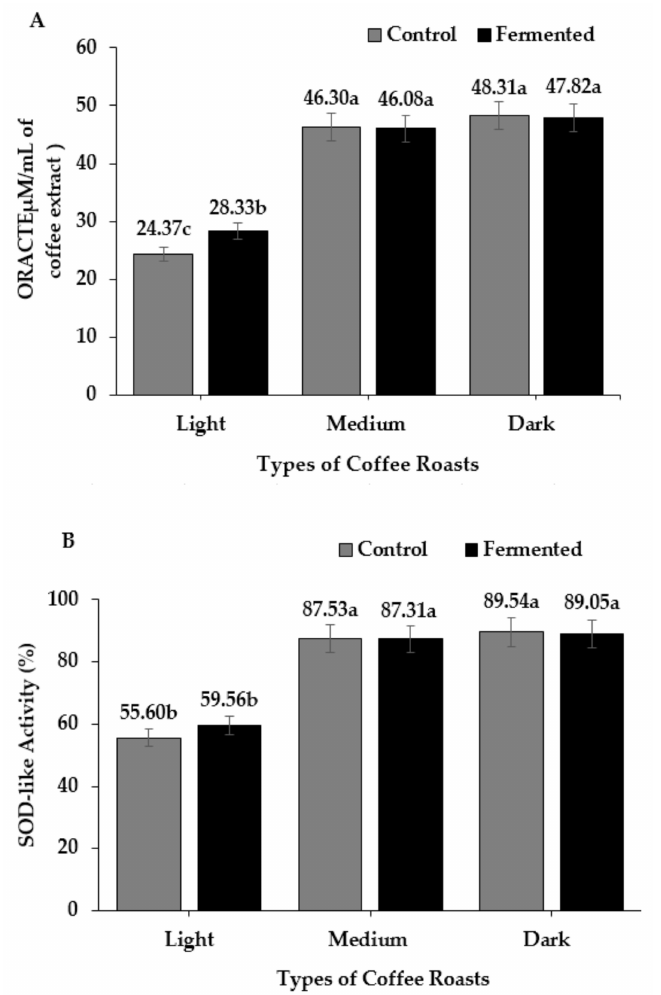
Figure 4. The oxygen radical absorbance capacity (ORAC) and superoxide dismutase-like (SOD)-like activity of fermented co ff ee at di ff erent degrees of roast ( A and B , respectively). Bars with di ff erent letters indicate a significant di ff erence ( p < 0.5) among